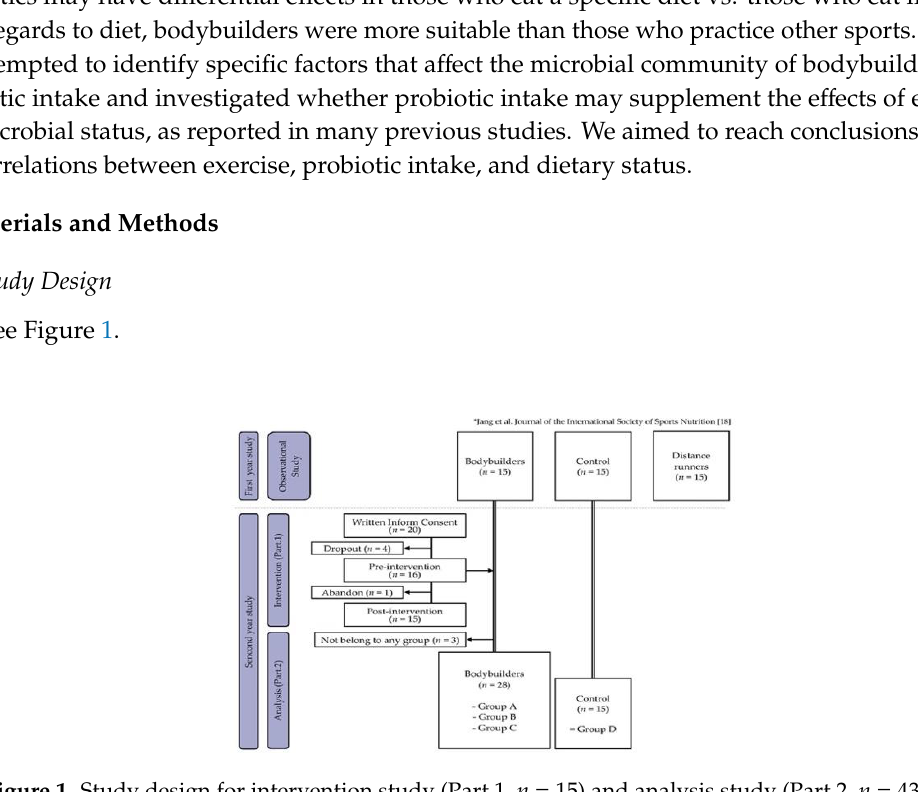
Figure 1. Study design for intervention study (Part 1, n = 15) and analysis study (Part 2, n = 43) [18].